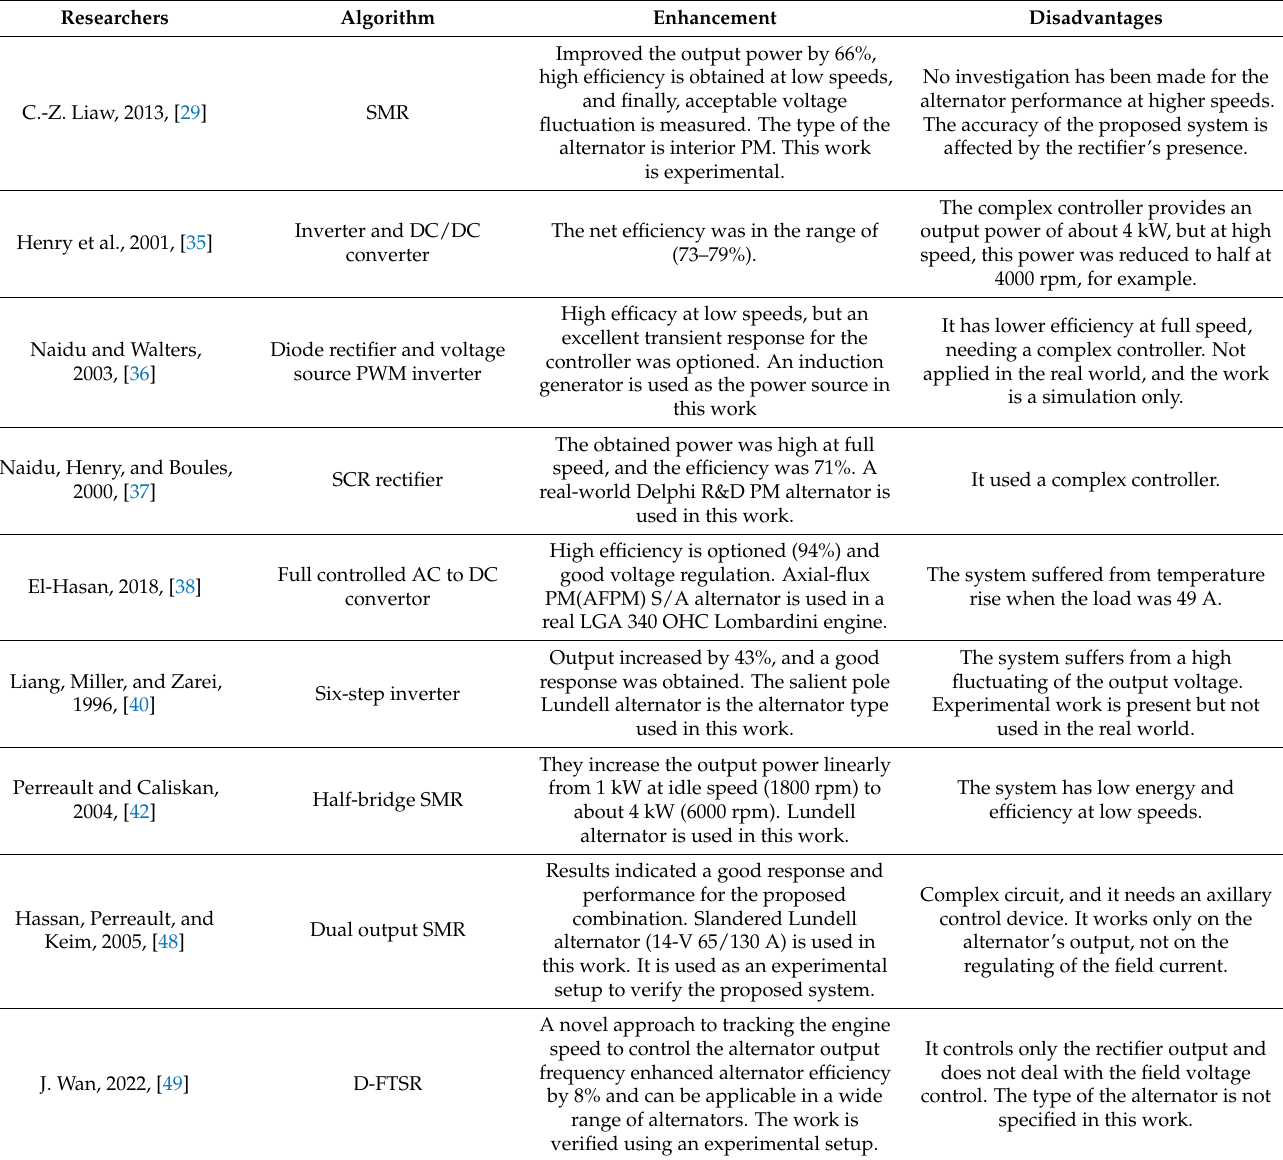
Table 3. Summary of Power Electronic Devices Effects on the Alternator